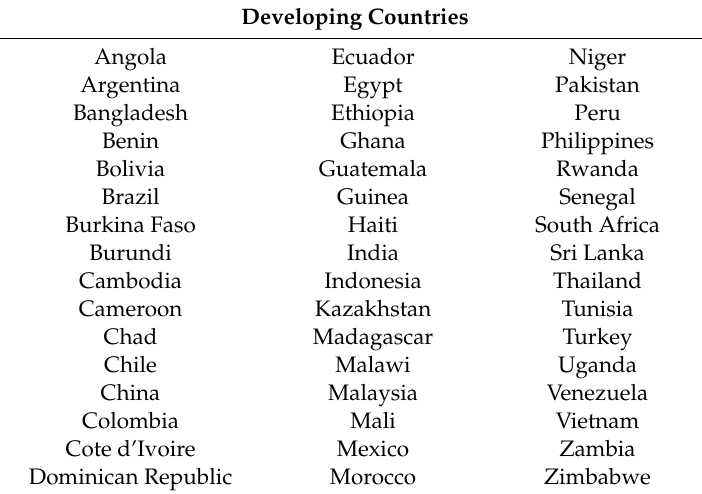
Table 4. List of 48 developing countries.